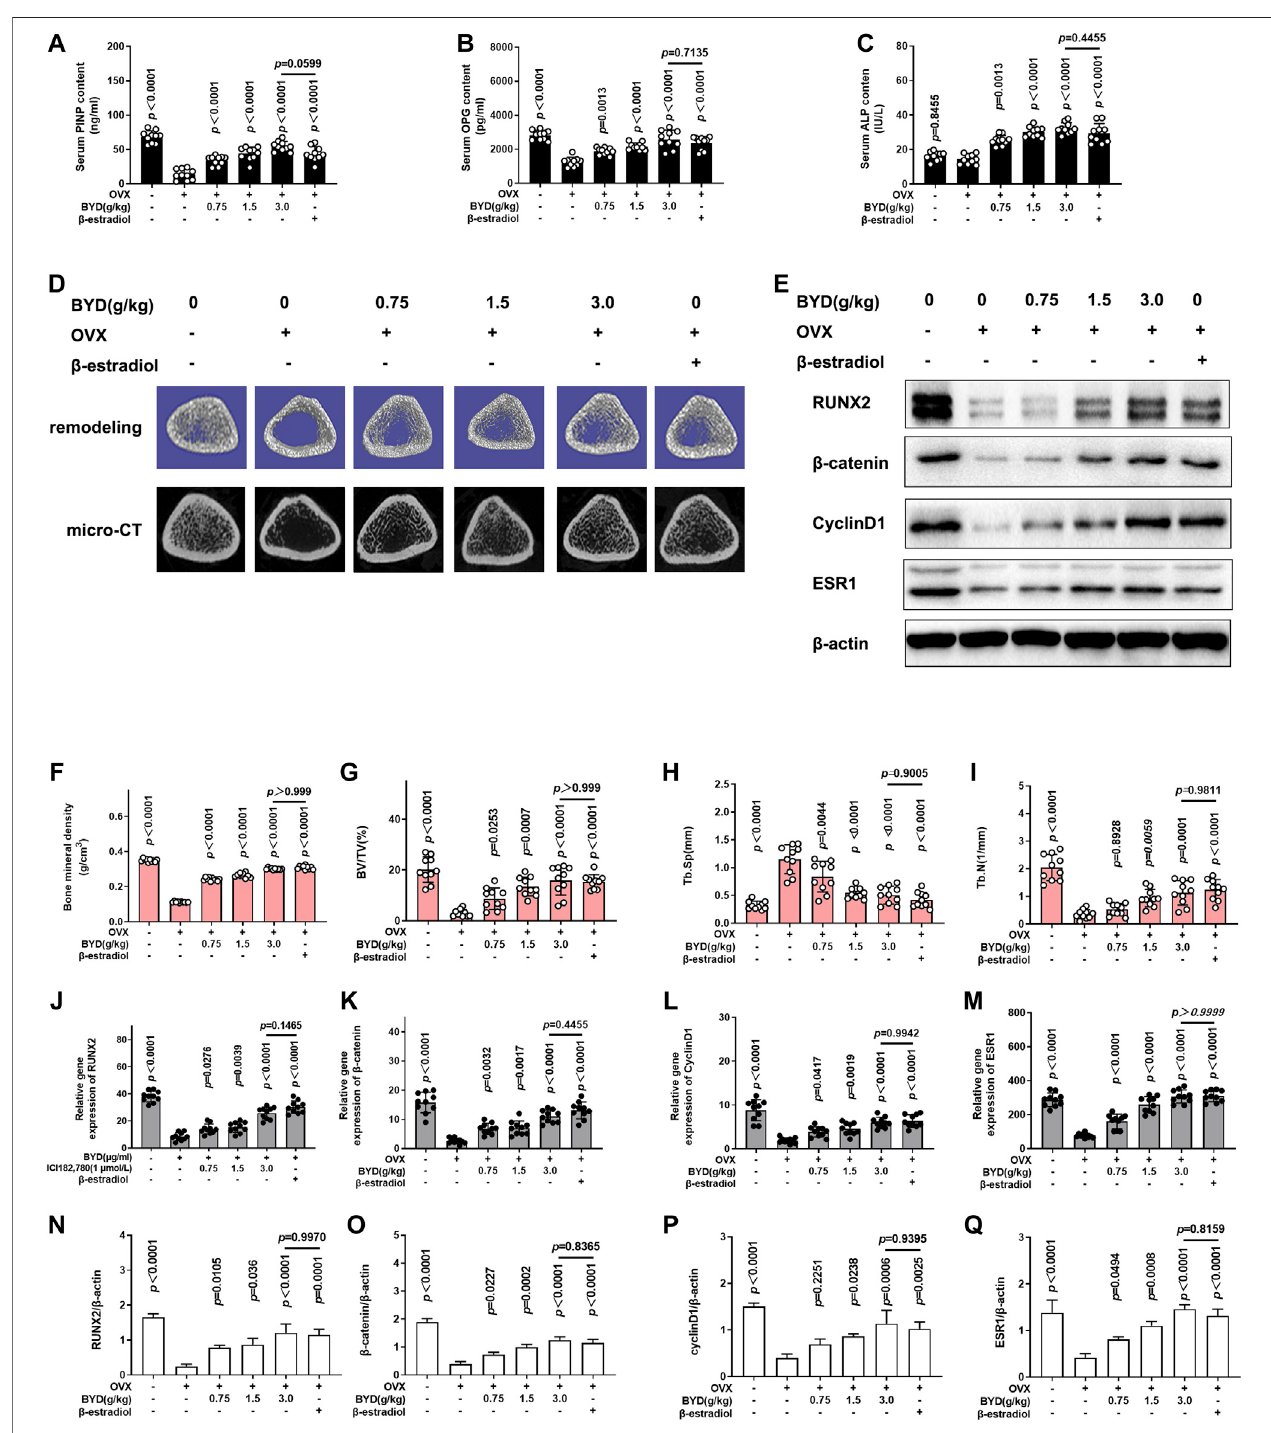
FIGURE 3 | BYD promoted bone mineral density and microarchitecture of bone in OVX-rats in a dose-dependent manner via ESR1. Bone metabolism index of serum (A) PINP, (B) OPG, and (C) ALP, detected by ELISA (D) Representative images of micro-CT scanning and 3-dimensional remodeling of the distal tibia. (E) RepresentativeimagesofwesternblotsofRUNX2, β -catenin,CyclinD1,andESR1.Quantitativeresultsofbonemorphometry,including (F) Bonemineraldensity, (G) BV/ TV, (H) Tb.Sp, and (I) Tb.N. Quantitative analysis results of mRNA expressions of (J) RUNX2, (K) β -catenin, (L) CyclinD1 and (M) ESR1, Quantitative analysis results of protein expressions of (N) RUNX2, (O) β -catenin, (P) CyclinD1 and (Q) ESR1. THE exact p -value can be found in the corresponding histogram.